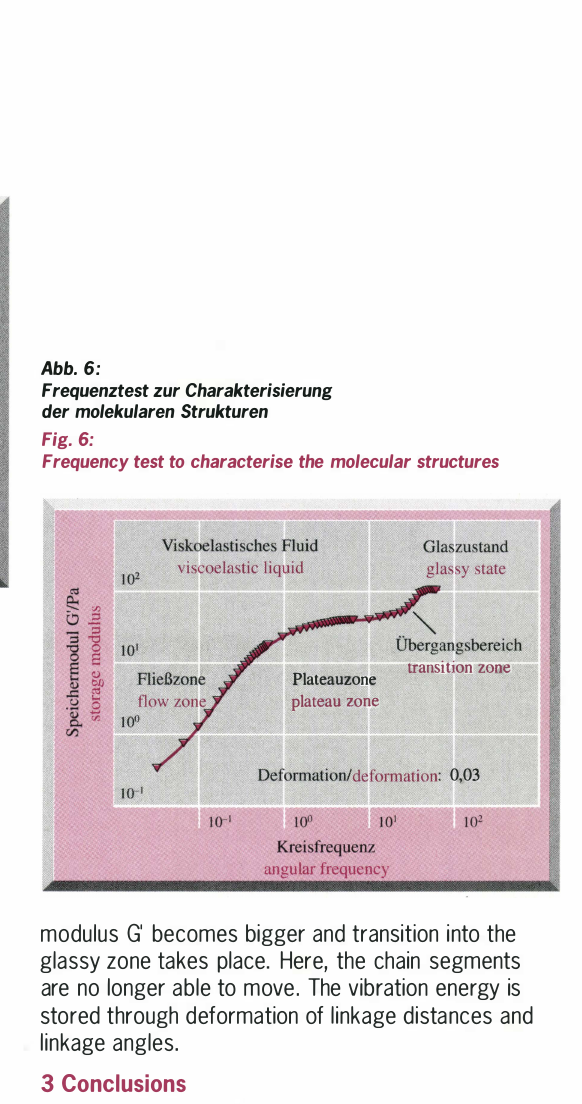
Deformation/deformation: 0,03